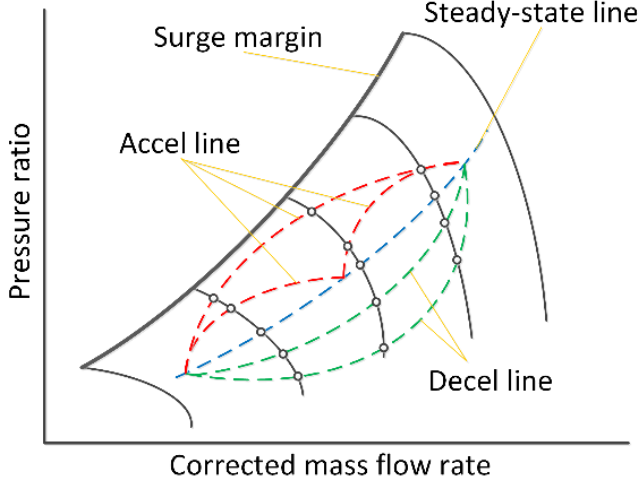
Figure 4. Operating line in the component map.